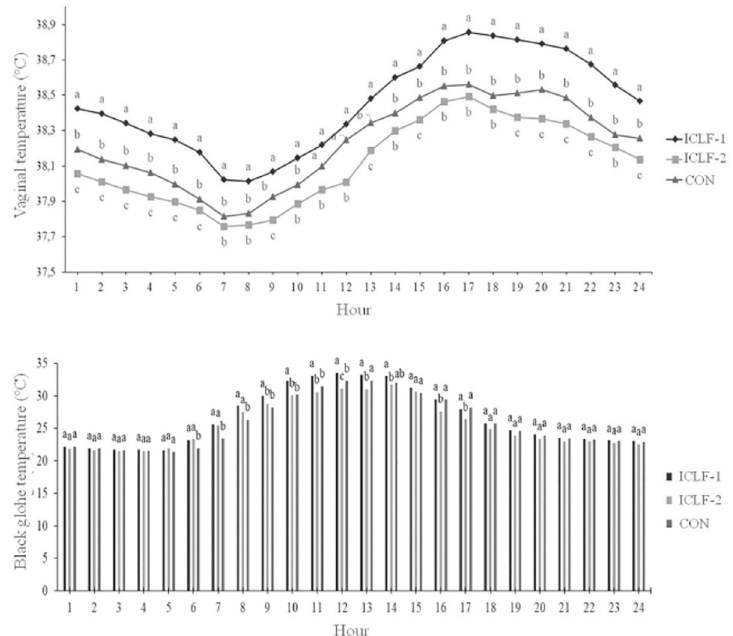
Fig 6. Average values of the system x time interaction of vaginal temperature measured in Nellore heifers, and the black globe temperature in integrated crop-livestock-forest (ICLF-1 and ICLF- 2) and control (CON) system. Bars with different letters between systems differ ( P < 0.05) by the Tukey